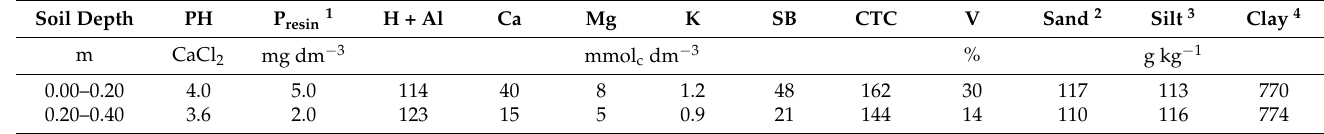
Table 1. Chemical and granulometric soil analysis of the experimental area in March 2017.